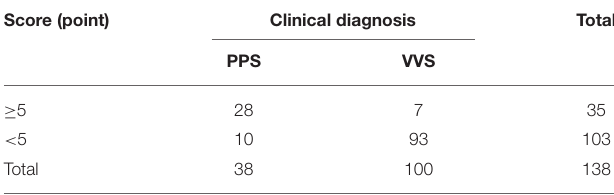
TABLE 5 | Predictive values of scoring model in external validation